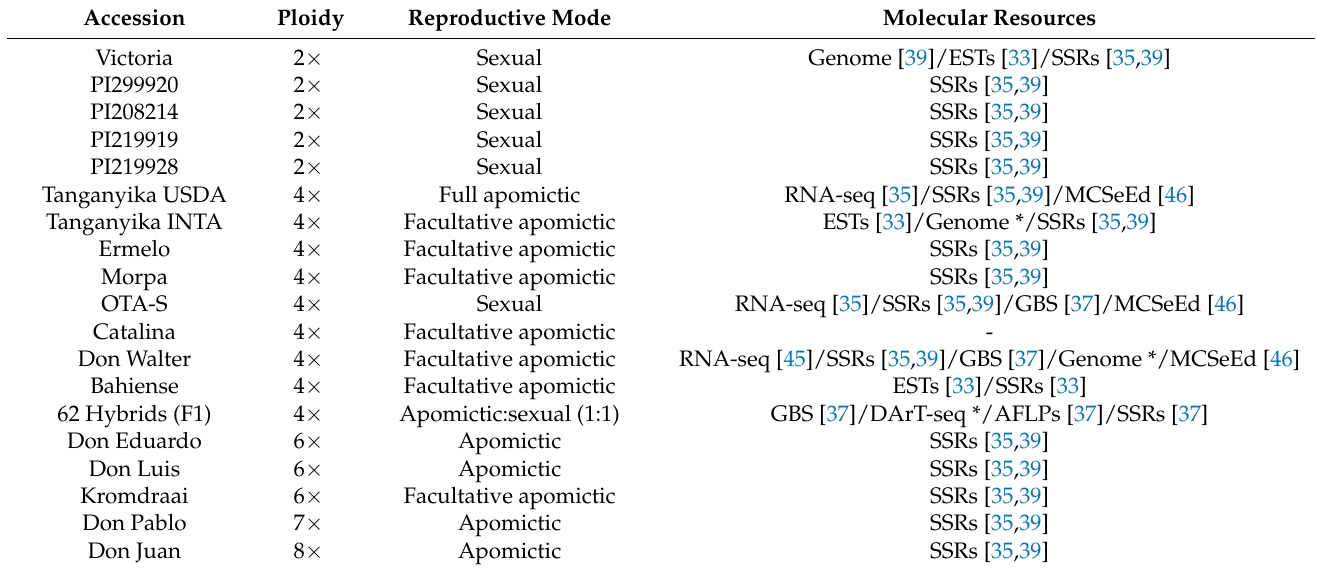
Table 1. E. curvula’s accessions available at CERZOS-CONICET in which different studies were performed. SSRs: single sequence repeats markers. GBS: genotyping by sequencing. ESTs: expressed sequenced tags. MCSeEd: Methylation Context Sensitive Enzyme ddRad. DArT-seq: Diversity array technology sequencing. *